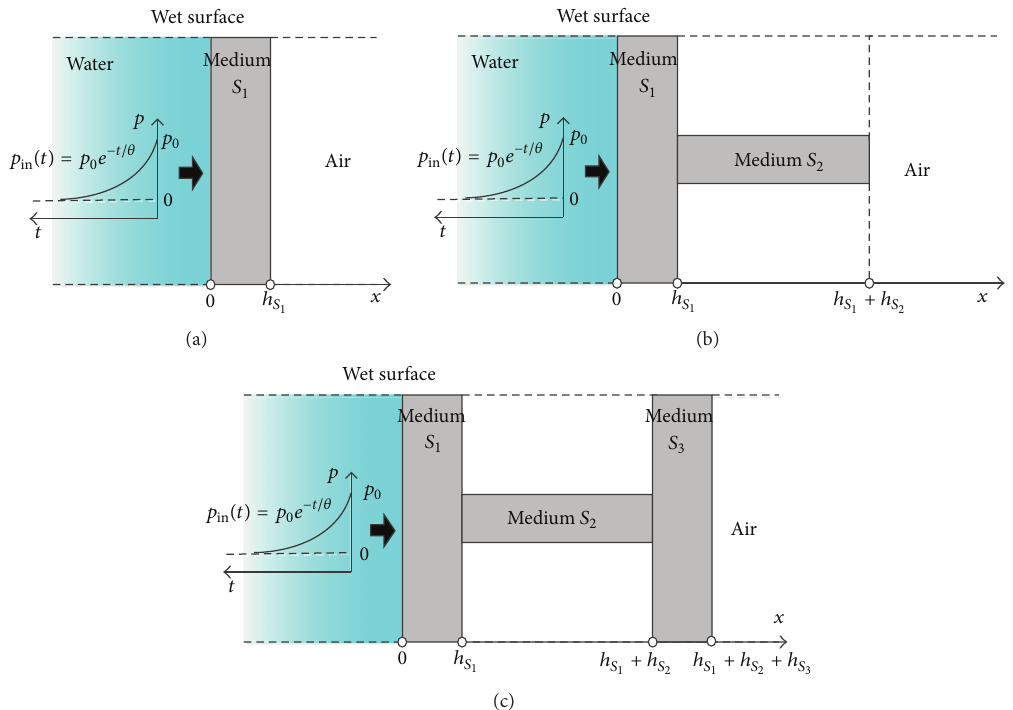
Figure 4: Sketches of geometry, reference system, and loading case for (a) the simple panel; (b) the panel with stiffener (T-shaped); (c) the panel with girder